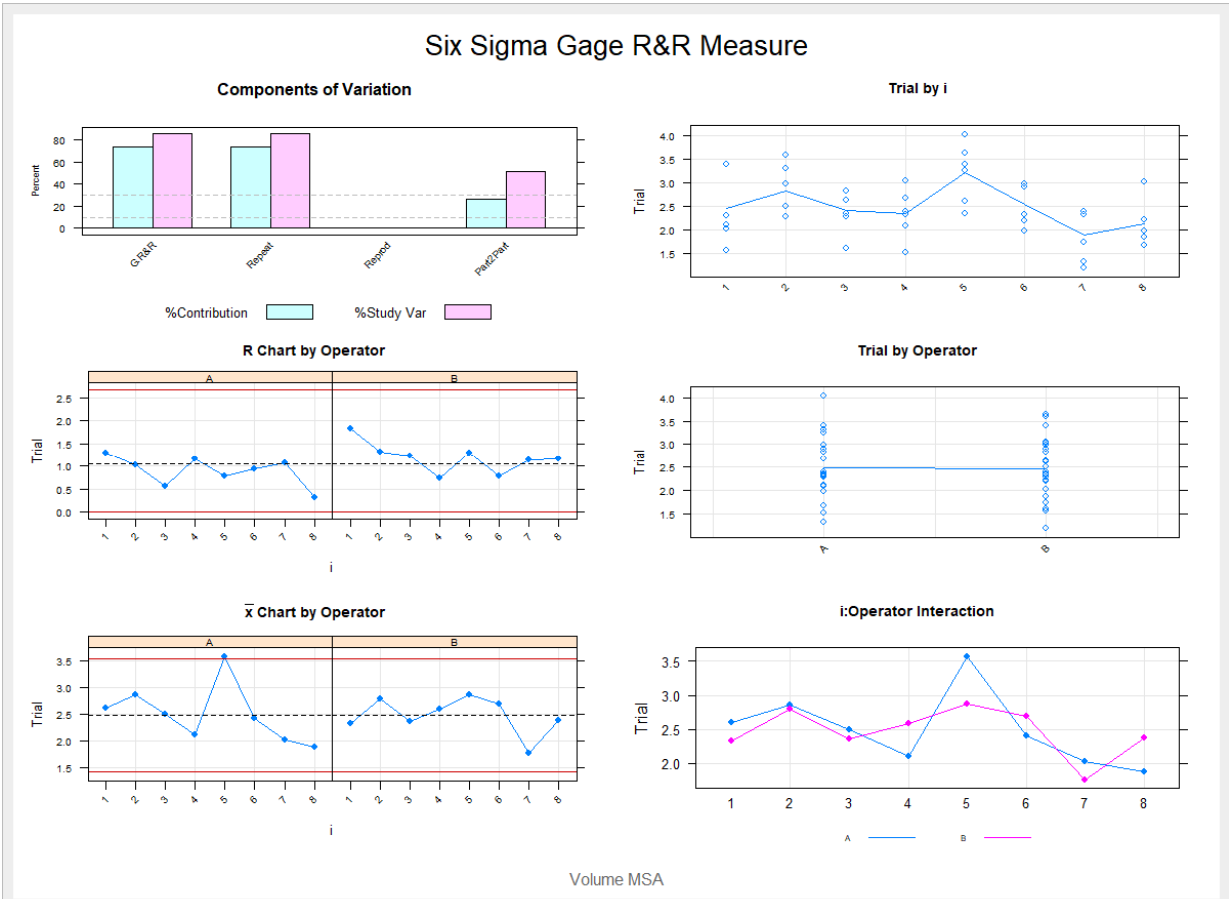
Figure 9. The graph shows the relationship of the lineal measurement analysis after palatal suture expansion following RME procedures through the McNamara appliance, with the contribution graph of each component to the total variance (Variance Components), mean control chart and range control chart (R Chart by Operator and x Chart by appr), each measurement point on the graph (Assay by I and Assay by Operator) and the interaction between the operators (i:Operator interaction). Operator 1 is defined as letter A and Operator 2 is defined as letter B.